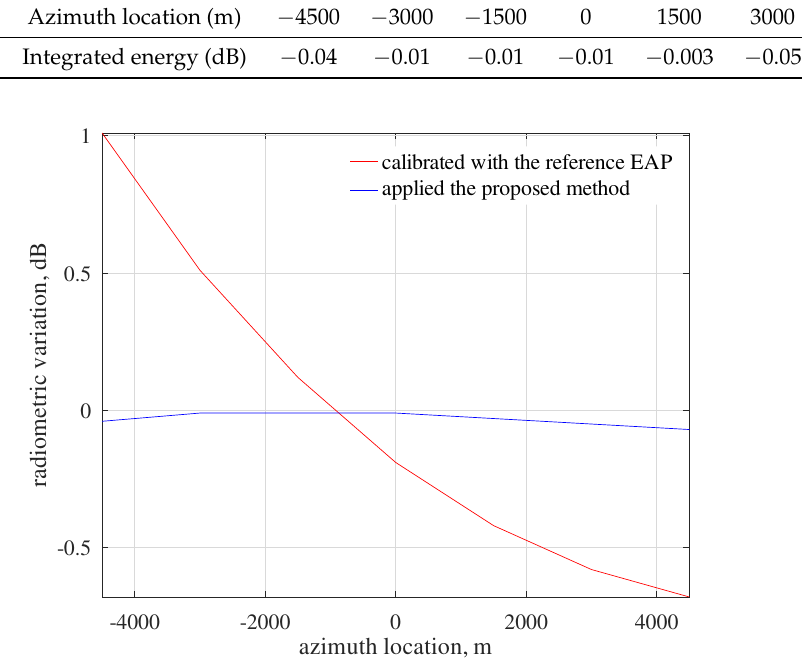
Figure 8. Comparison of azimuth radiometric variation: about 1.69 dB calibrated using the reference EAP, about 0.1 dB calibrated using the proposed method accounting for the 2D antenna